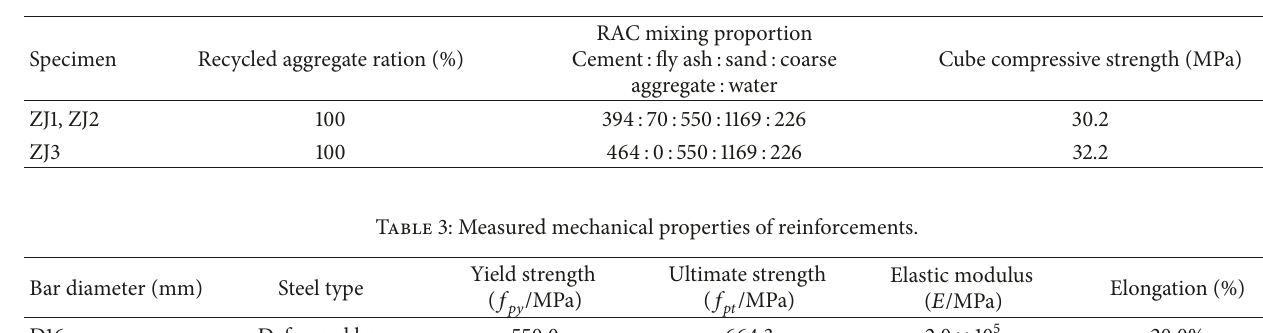
Table 2: RAC mix properties and compressive strength.